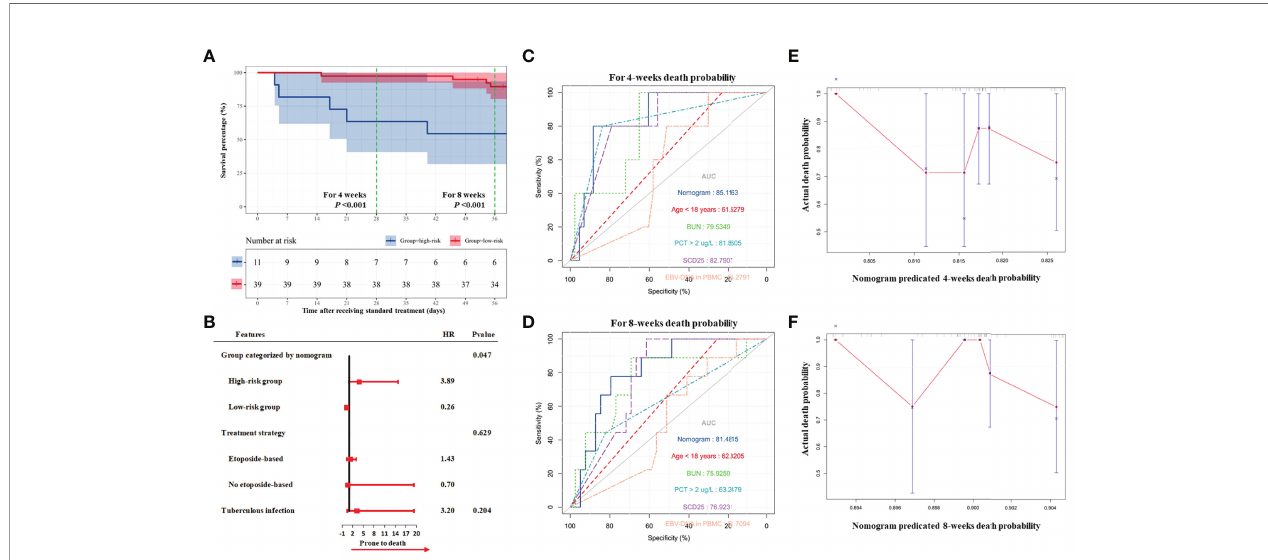
FIGURE 4 | Validation of nomogram for death in induction therapy. (A) On the basis of validation cohort, the survival analysis showed that high-risk patients had higher risk of death. (B) The result of multivariate Cox analysis. The result showed that the high-risk group categorized by nomogram was related to high risk of death. (C, D) The predicted accuracy of nomogram and other risk factors for 4- and 8-week death. (E, F) The calibration analyses showed that the death predicted by nomogram was consistent with the actual death. Bun, blood urea nitrogen; PCT, procalcitonin; EBV, Epstein – Barr virus; DNA, deoxyribonucleic acid; PBMC, peripheral blood mononuclear